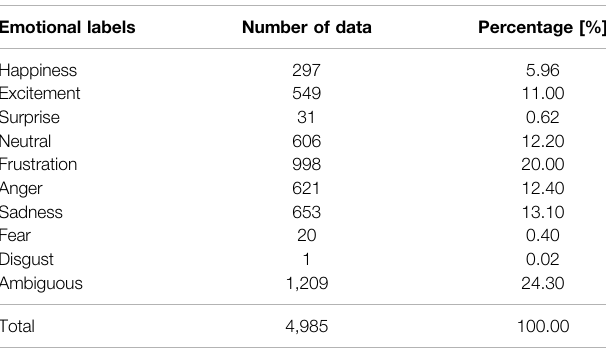
TABLE 1 | Amount and percentage of emotional